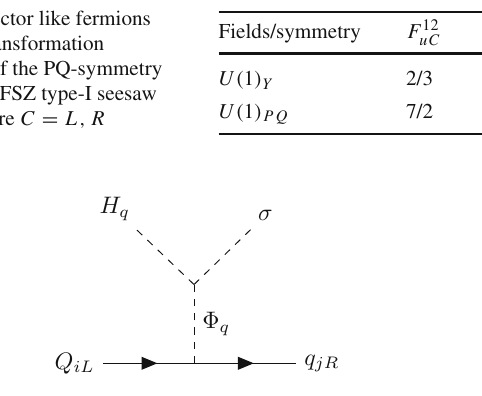
Fig. 2 UV complete diagram within the DFSZ type-II seesaw frame- work as apparent from Eqs. (15), and